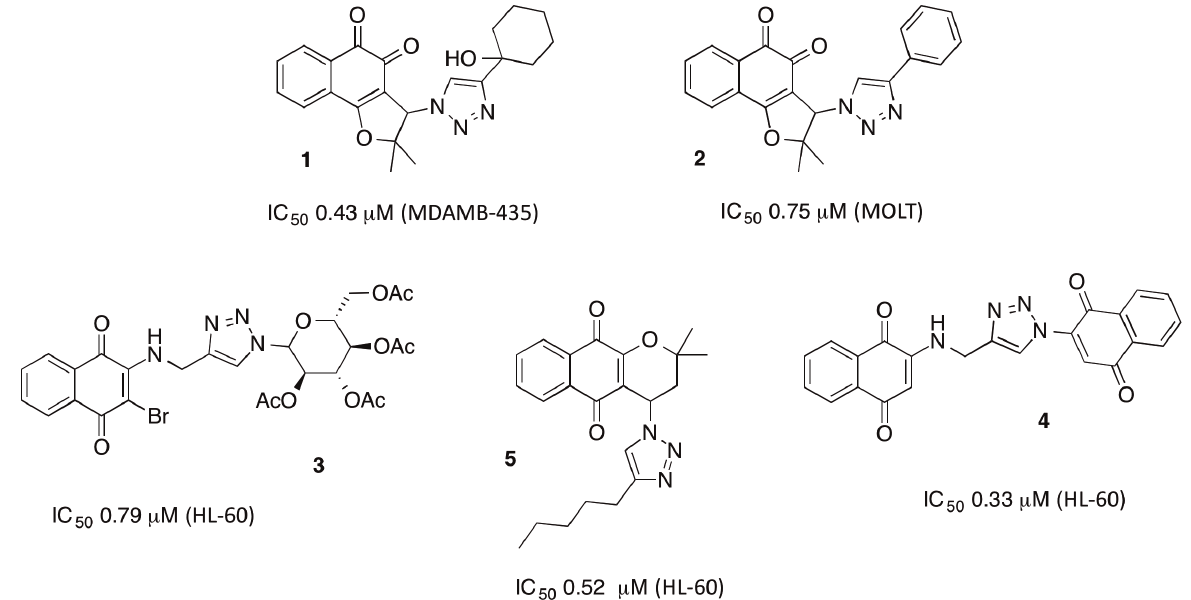
Figure 1 - Examples of cytotoxic hybrids naphthoquinones